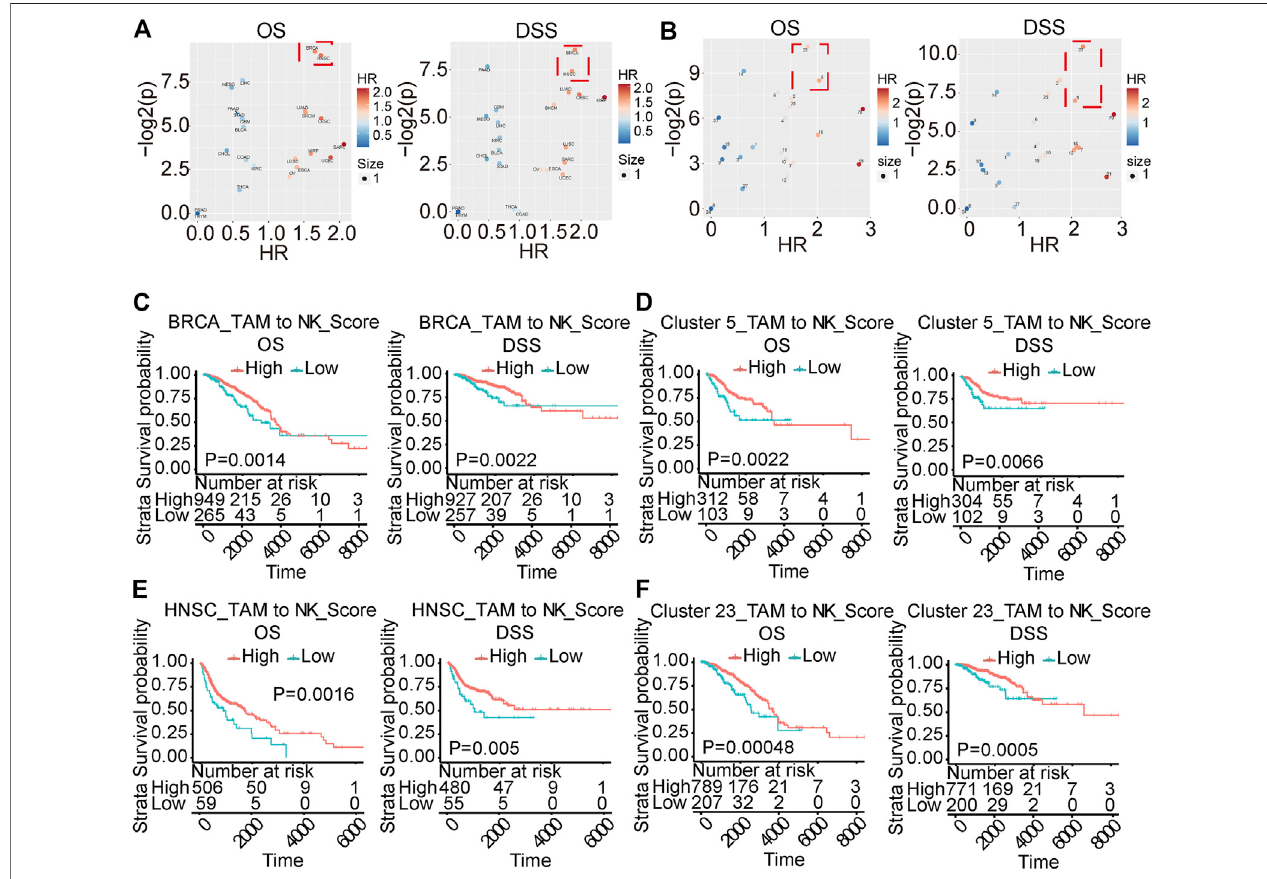
FIGURE 8| TAMtoNK Score predicts the prognosis of TCGA tumor patients. (A,B) Volcano chart ofhazard ratio based on TAM-to-NK Score grouping of patients with different types of cancer or different clusters. (C – F) Survival analysis of TCGA tumor type or clusters with signi fi cant High hazard ratio. OS and DSS respectively represent overall survival and disease-speci fi c survival